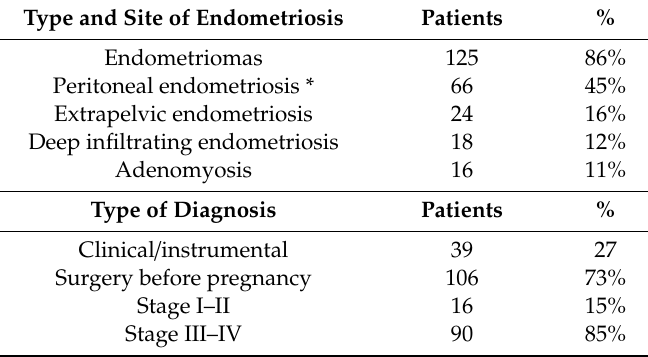
Table 2. Characteristics of endometriosis (145 patients).